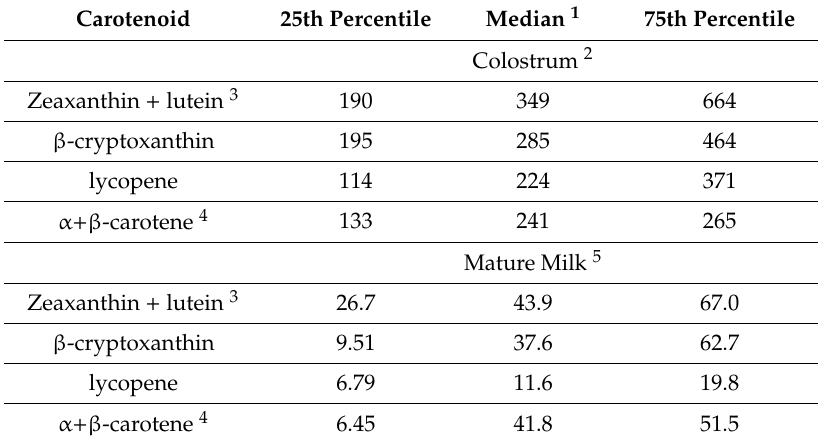
Table 1. Carotenoid content in colostrum and mature human milk ( n = 30). Data are expressed in ng /